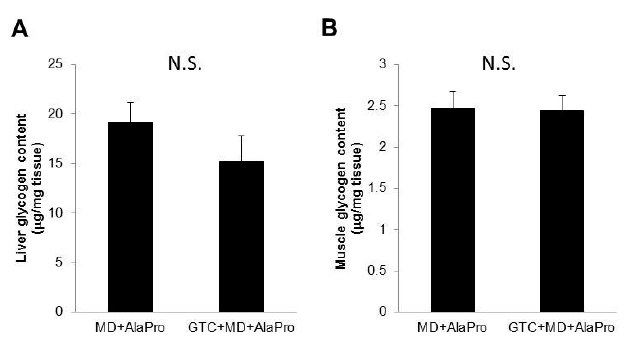
Figure 4. Glycogen storage in ( A ) liver and ( B) gastrocnemius muscle after running exercise. Both control and GTC group mice were fed MD + AlaPro 60 mins before running and ran on the treadmill for 60 mins at 20 m/min. Subsequently, the liver and muscles were collected. Values are means ± SE ( n = 8). N.S., not